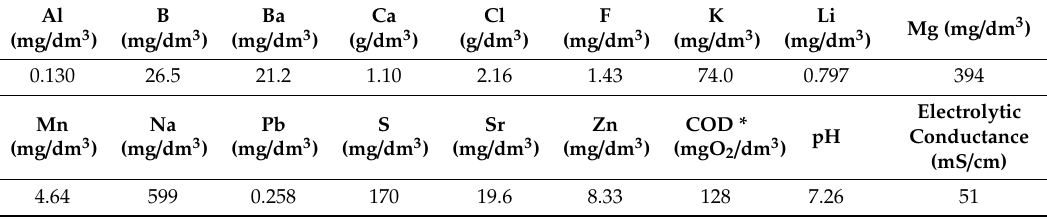
Table 1. Soluble constituents, pH reaction, and electrolytic conductance of the tested flue gas desulfurization (FGD)